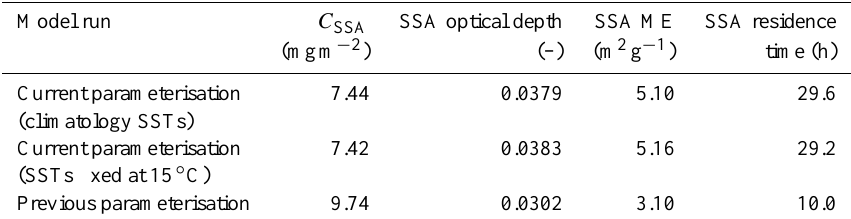
Table 4. Comparison of global averages (median) of sea spray aerosol column burdens ( C SSA ), all-sky sea spray aerosol optical depth, mass-specific extinctions (ME), and sea spray atmospheric residence times between the three NorESM model runs.